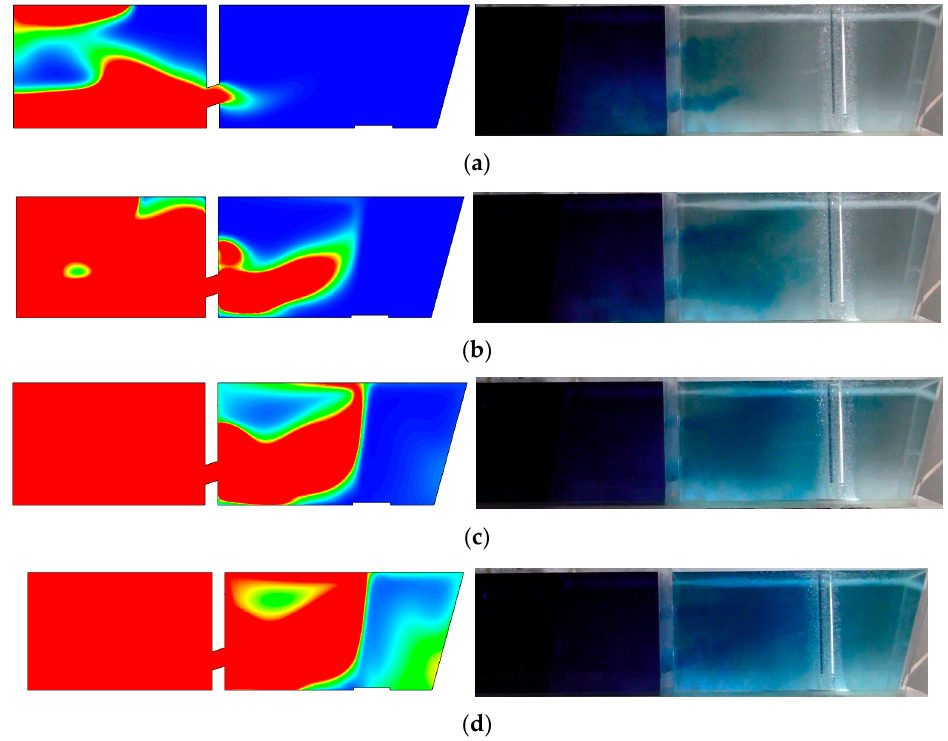
Figure 5. Flow field of the tracer in the half-tundish at different times of numerical model (left-hand diagram ) and experiment (right-hand diagram ): ( a ) 10 s, ( b ) 20 s, ( c ) 30 s, and ( d ) 40 s.